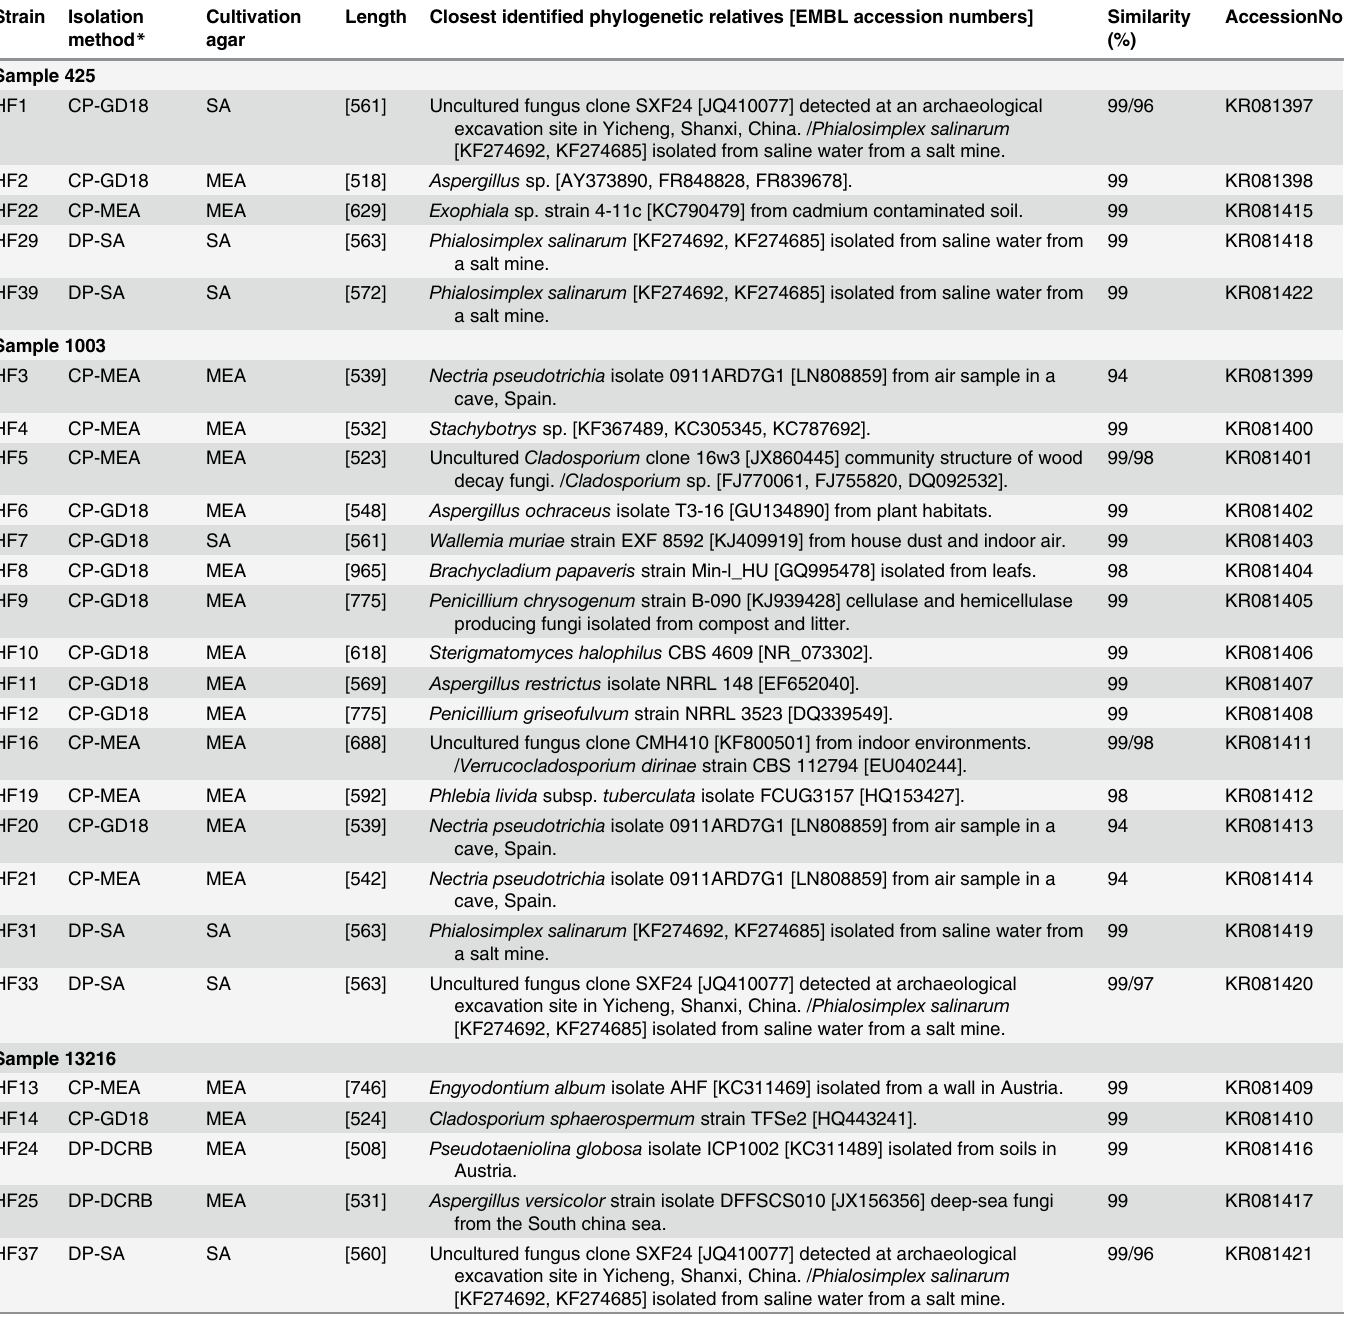
Table 1. Phylogenetic affinities of the ITS coding sequences amplified from pure fungal strains isolated from the staircase of Hallstatt. Strain Isolation Cultivation method *